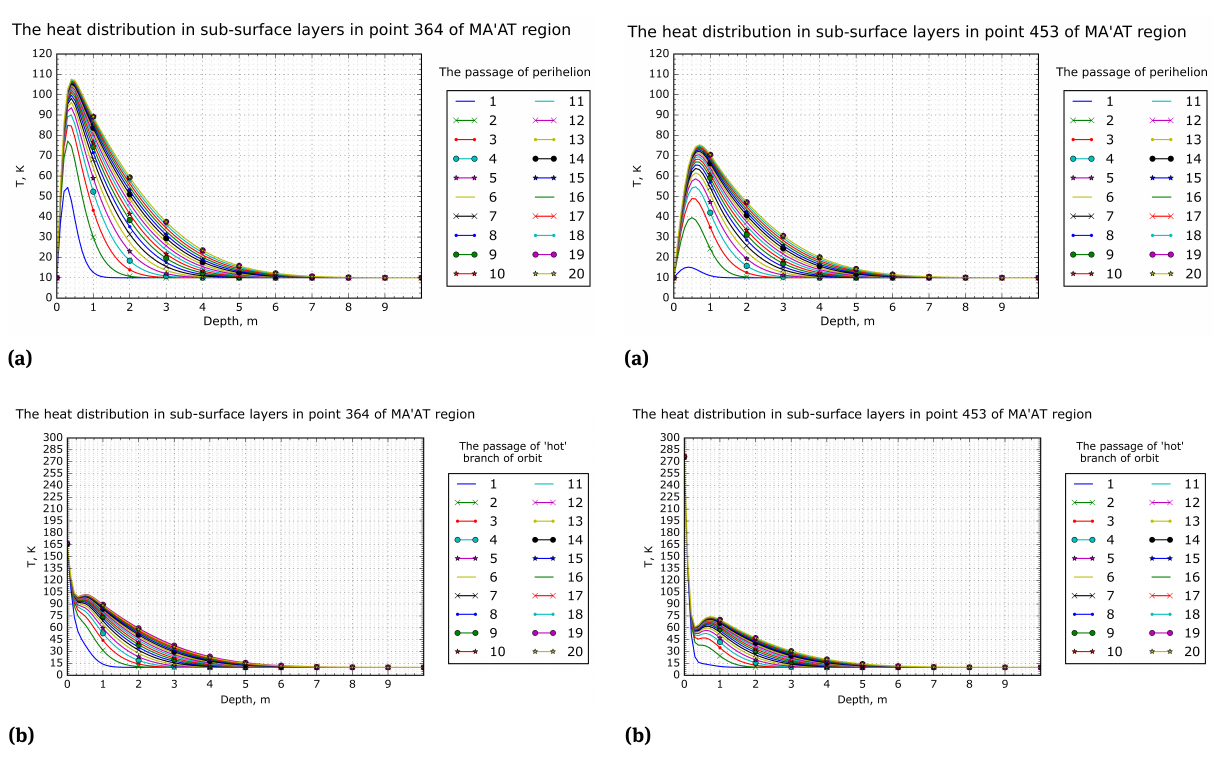
Figure 5. The depth temperature distribution in the point 364 of MA’AT region for the 20 comet orbital revolution